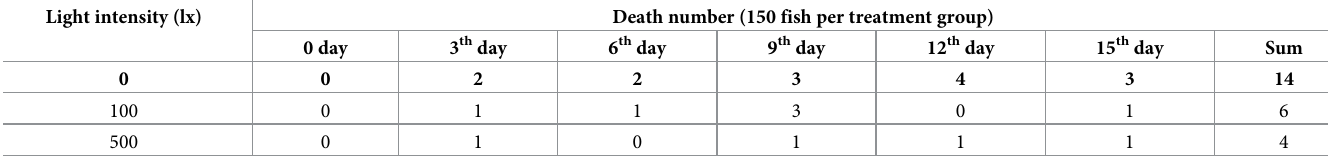
Table 3. Numbers of deaths of Nile tilapia every 3 days under different light levels. Light intensity (lx)